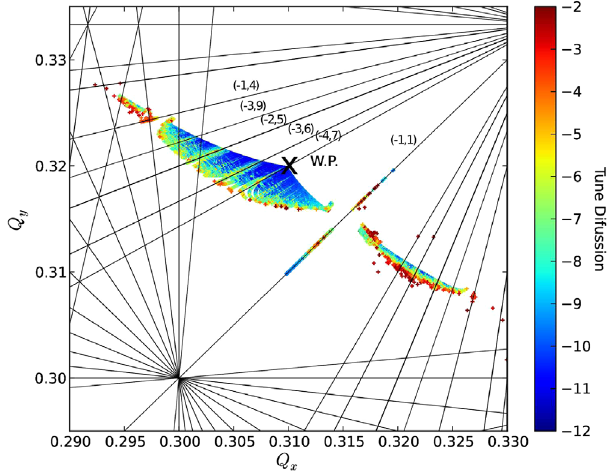
FIG. 17. Diffusion factor on a tune map for the initial angles varying from 0 – 90 degrees and initial amplitudes I ¼ 0 – 22 σ over a resonance diagram of order 12 for the lattice with L (cid:1) ¼ 10 m and β (cid:1) ¼ 10 cm.